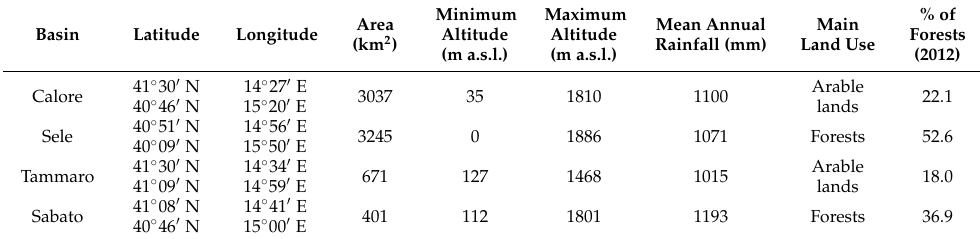
Table 1. Main features of the investigated rivers.